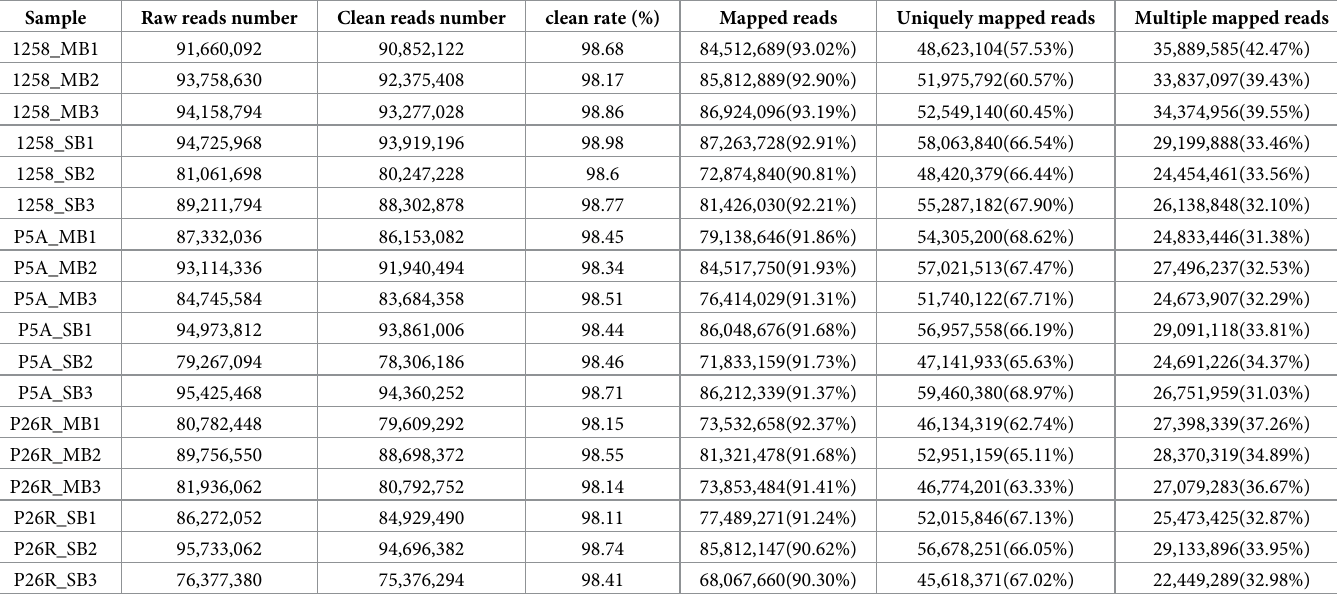
Table 1. Statistical analysis of RNA sequencing data.